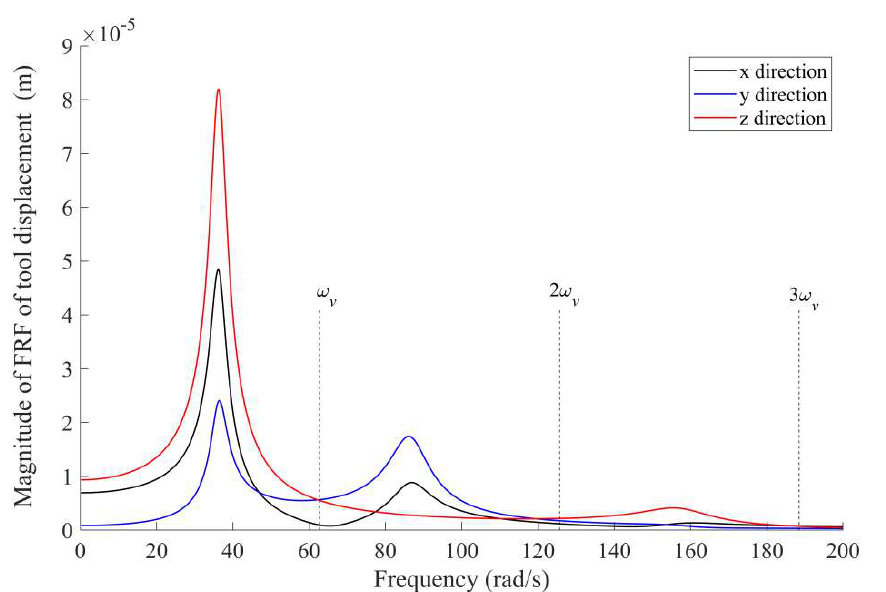
Figure 11. Frequency response function of tool displacement at P 1 under a force along—X direction.